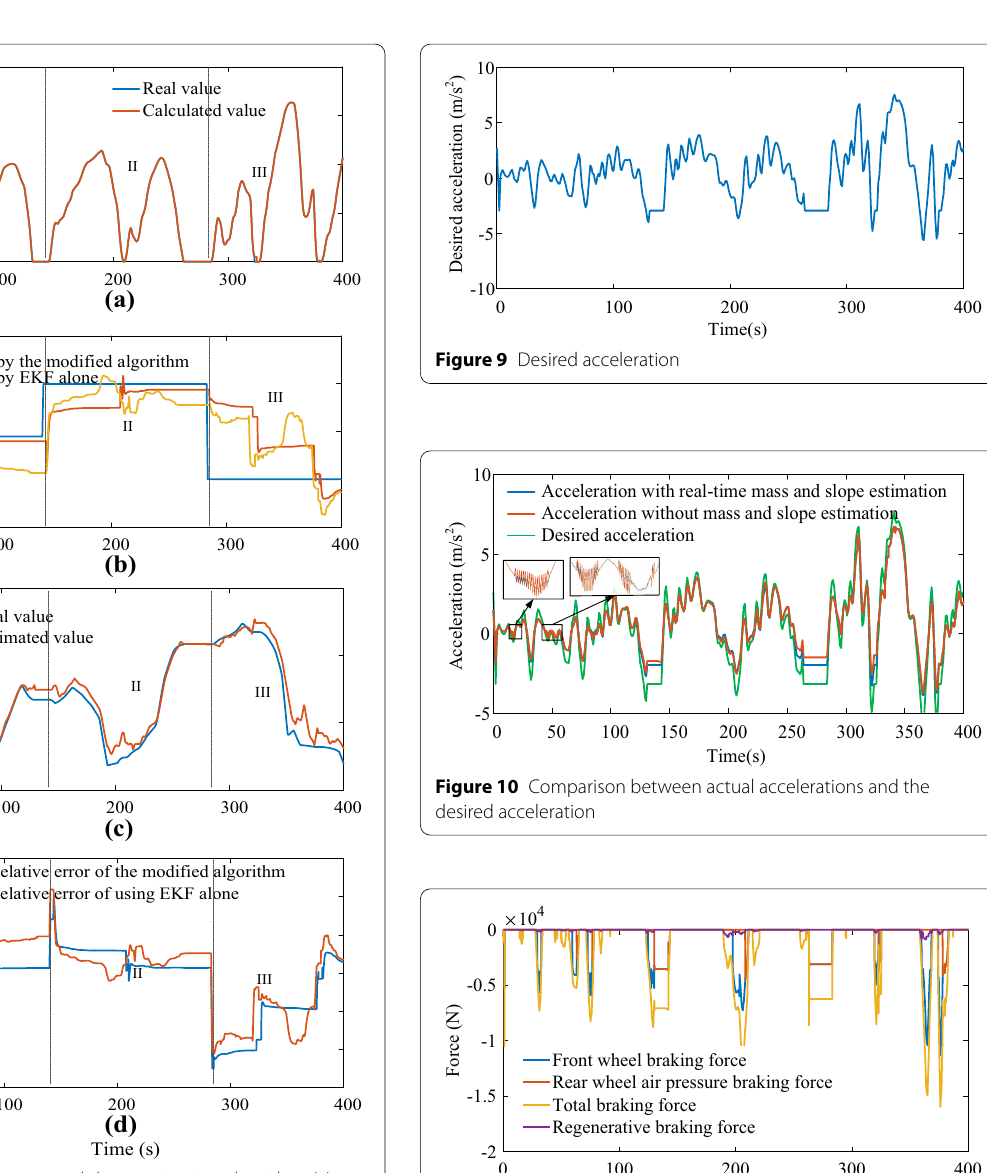
Figure 11 Simulation results of braking force